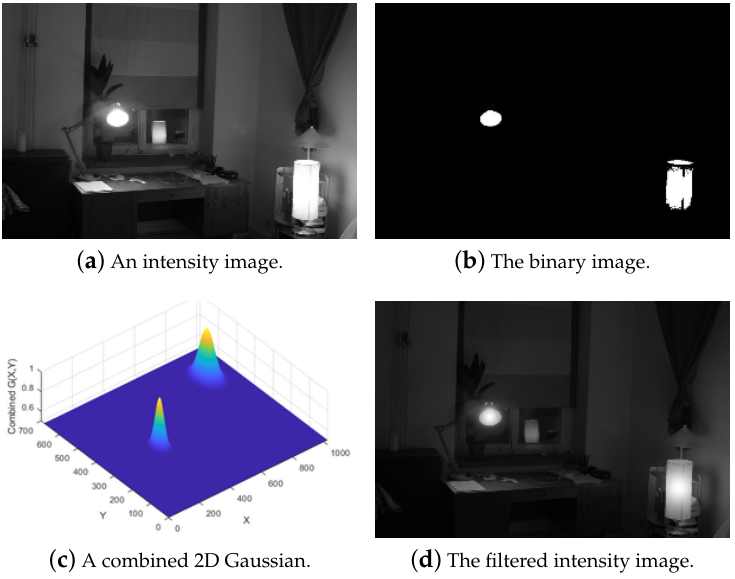
Figure 3. An overview of the filtering of an intensity image with a combined multi-layered 2D